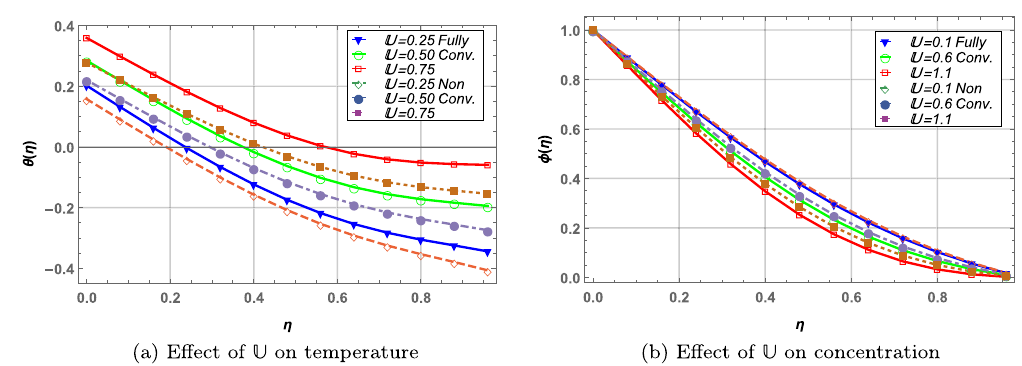
Figure 5. Effect of unsteady parameter (fully convective vs. non-convective) on temperature and concentration